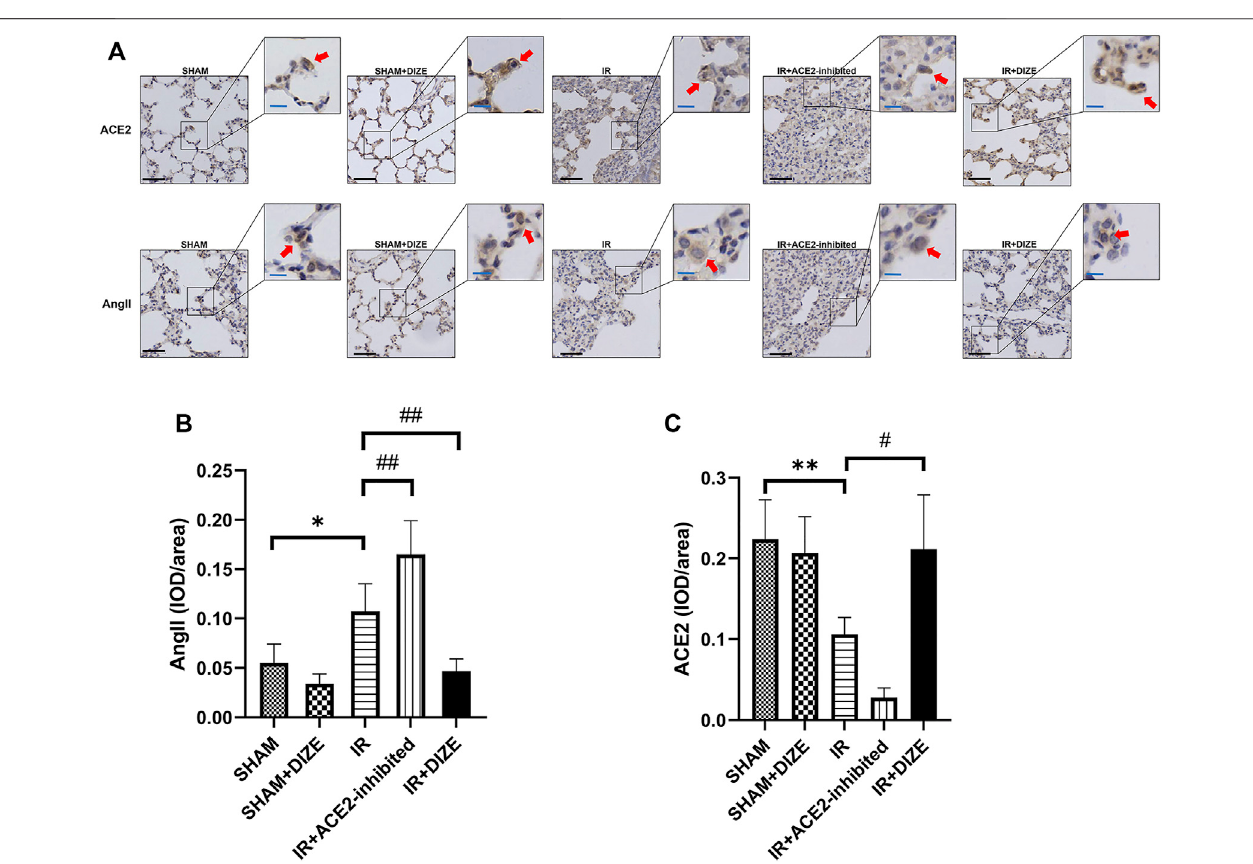
FIGURE 5 | Expression of ACE2 and AngII detected by immumohistochemical (IHC) staining in rat lungs. DIZE signi fi cantly decreases AngII expression in lung tissue, and preserved a higher level of endogenous ACE2 expression during IR injury. (A) IHC staining results of ACE2 and AngII in rat lung (lower left, black scale bar 50 μ m,upperright,bluescalebar20 μ m). (B) Semi-quanti fi cationofAngIIexpression(post-hocanalysis:Dunnett ’ sT3test). (C) Semi-quanti fi cationofACE2expression (post-hoc analysis: Dunnett ’ s T3 test). Mean density (cid:1) IOD/area, which represented the relative concentration of the protein in the area of interest. Data were expressedasmean ± SEM( n (cid:1) 7;representativeimagesareshown). *p < 0.05, **p < 0.01, ***p < 0.001vs. SHAMgroup ; # p < 0.05, ## p < 0.01, # ## p < 0.001vs. IRgroup .